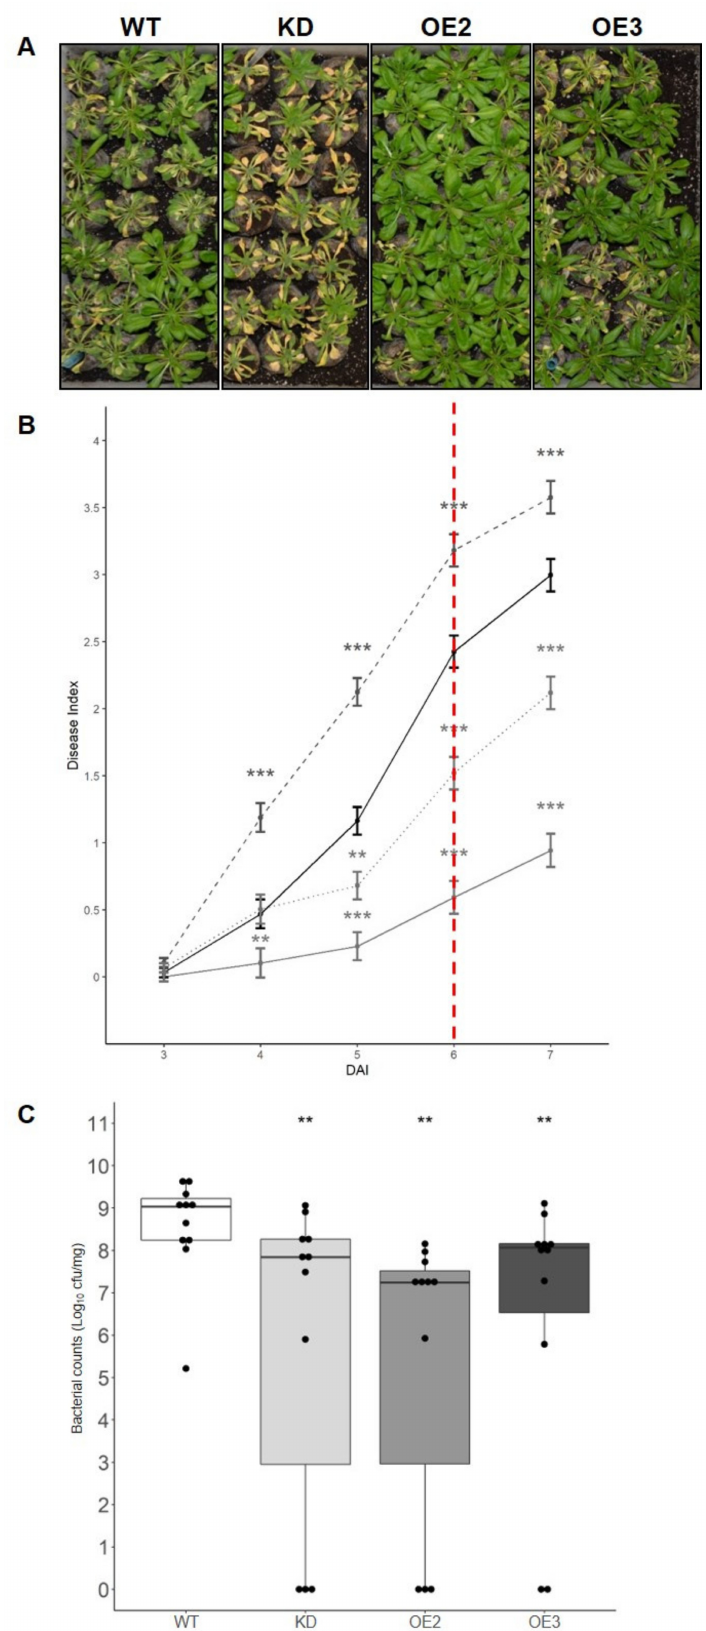
Figure 3. Comparative analysis of the susceptibility of CML8 genotypes upon inoculation with Rs GRS100 strain that is deleted for the effector PopP2 complemented with PopP2. Cut roots of four weeks-old plants of WT, CML8 KD line and OE lines were inoculated with a suspension of 1 · 10 7 cfu · mL